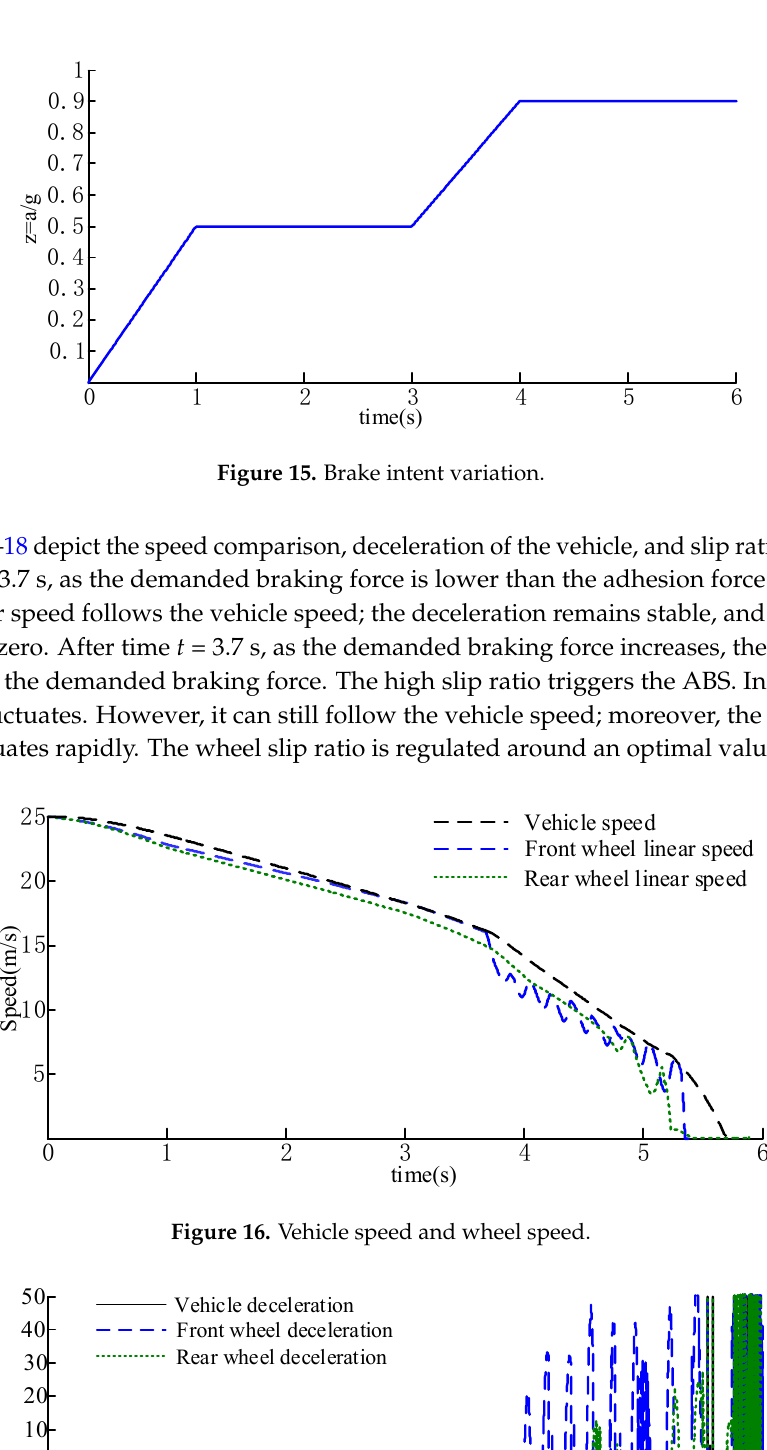
Figure 17. Vehicle and wheel deceleration.